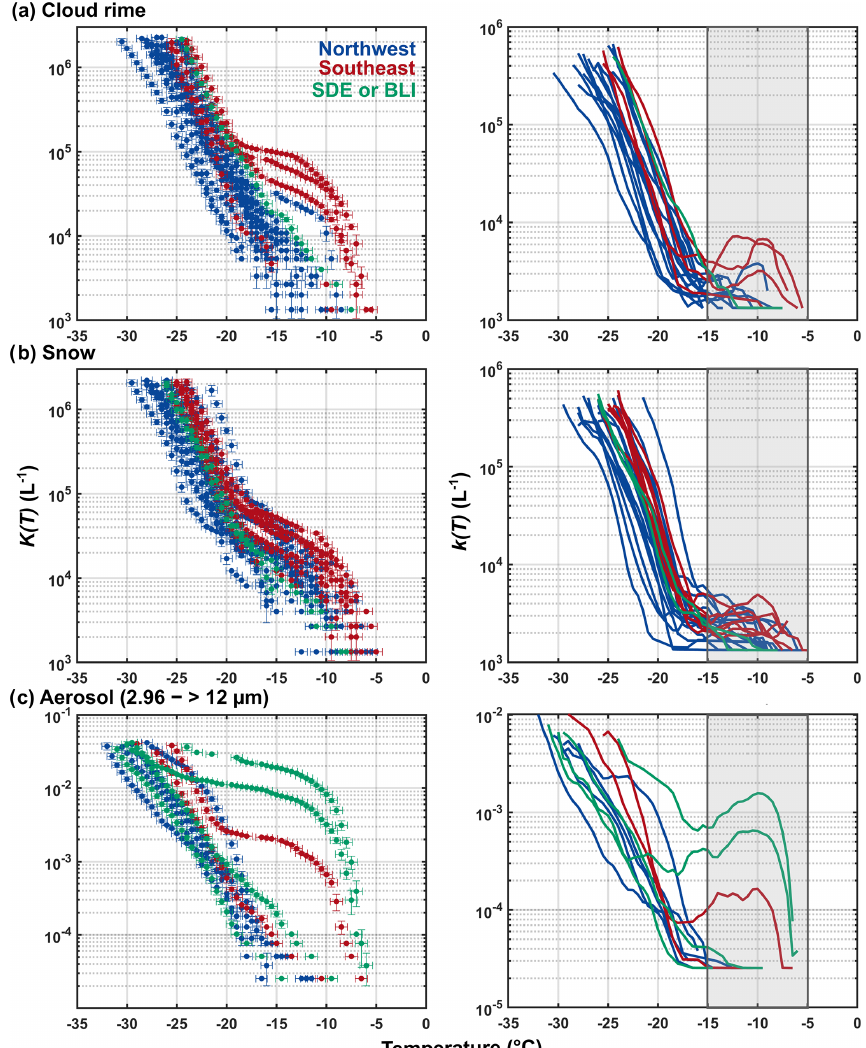
Figure 5. Cumulative INP spectra ( K(T ) , on left) and differential INP spectra ( k(T ) , on right) for the same samples of (a) cloud rime, (b) snow, and (c) aerosol for the size range 2.96– > 12µm in diameter. Spectra shown are for samples from the northwest (blue) and southeast (red) case study dates, in addition to SDE and boundary layer intrusion (BLI) case days (green). Multiple cloud rime and snow samples were collected while one aerosol sample from each size range was collected on northwest and southeast case study days (see Table 1). The warm-mode region is indicated by the dark grey shading in the k(T ) spectra. Note the axes are not all the same